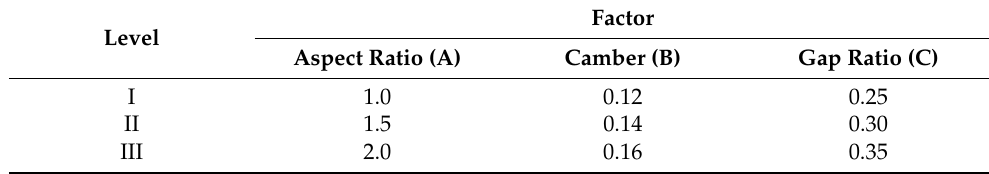
Table 1. Factors of the orthogonal